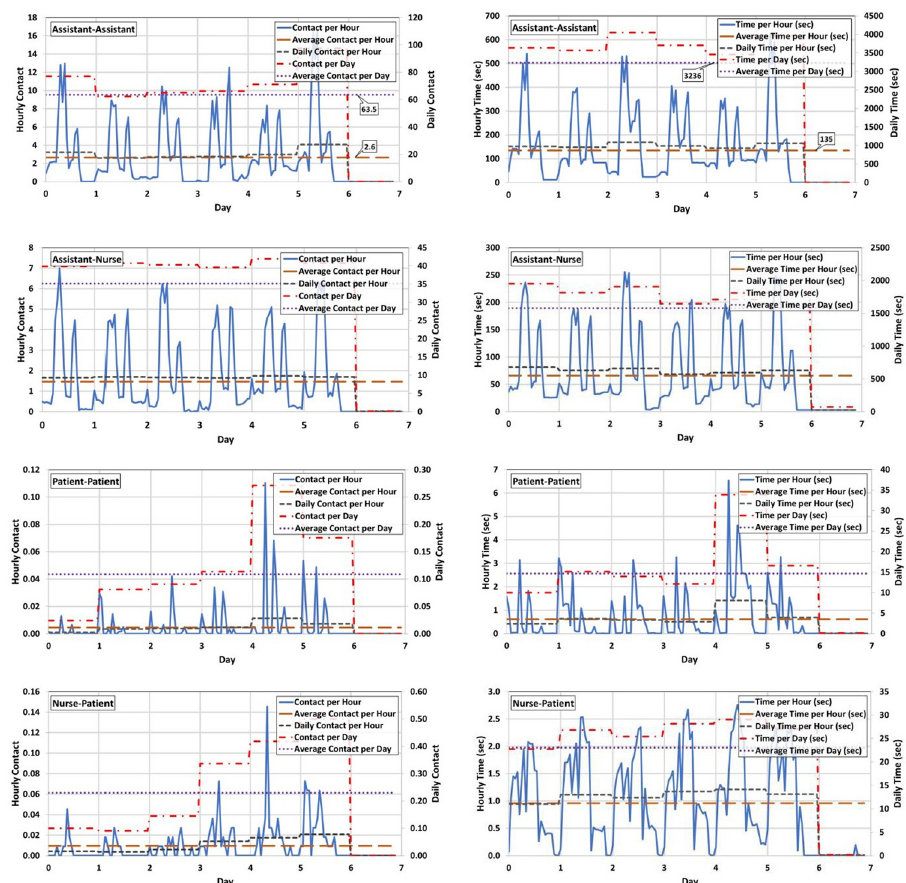
Fig 7. Time series of the hourly/daily cumulative number (left charts) and time (right charts) of connections during a one-week simulation of the normal schedule of the dialysis department.